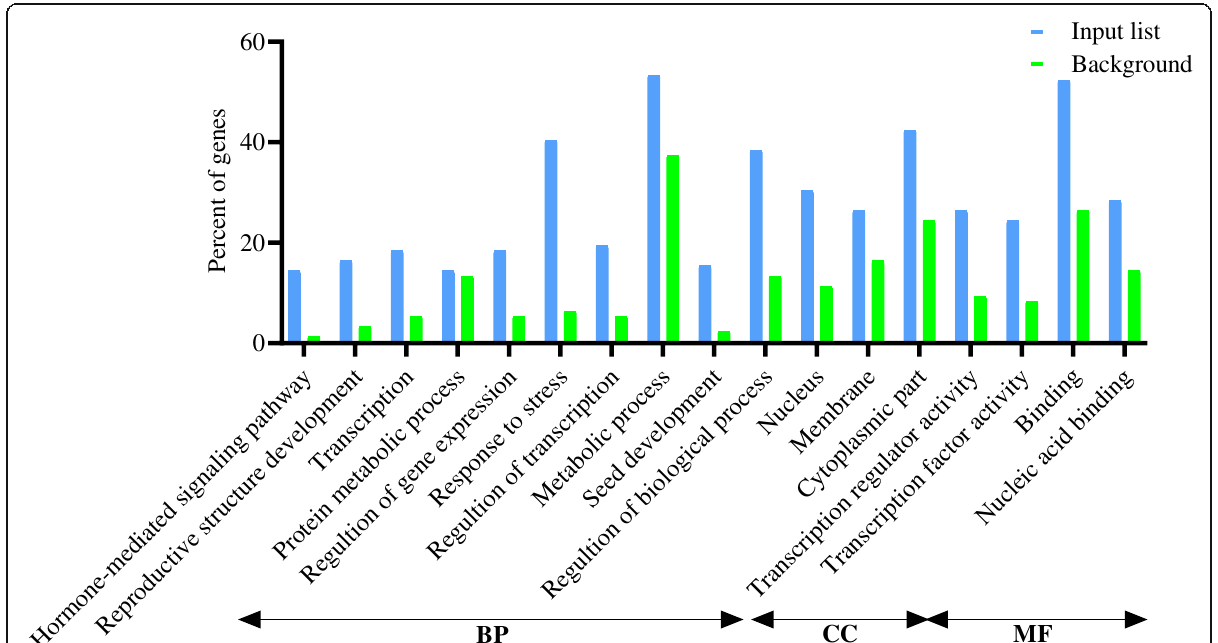
Fig. 4 Gene Ontology enrichment analysis (BP, biological processes; CC, cellular components; and MF, molecular function) of the determined hub genes at drought stress conditions in vegetative and reproductive stage barley based on microarray data using agriGO